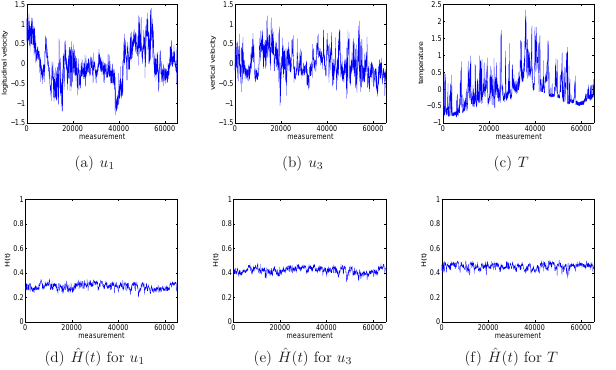
Figure 5: Two velocity ((a) longitudinal u 1 and (b) vertical u 3 ) and (c) tempera- ture T signals under stable conditions from the 12th run are shown in the upper row. The corresponding estimated H ( t ) are shown in the lower row.